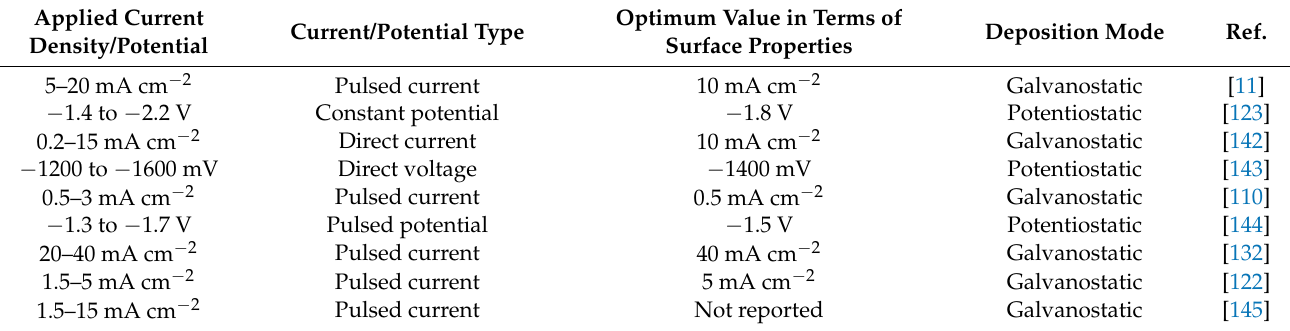
Table 3. Applied current density/potential, current/potential type, and deposition mode during the electrodeposition of pure HAp